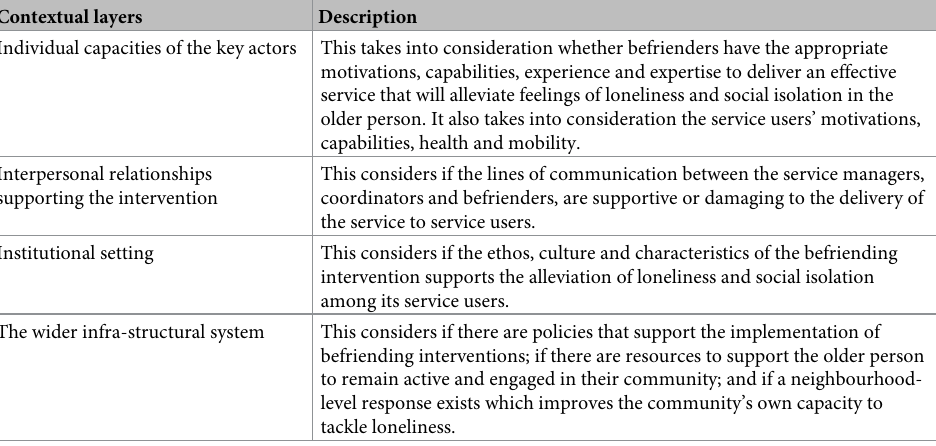
Table 1. Contextual layers of reality [26] in regard to befriending